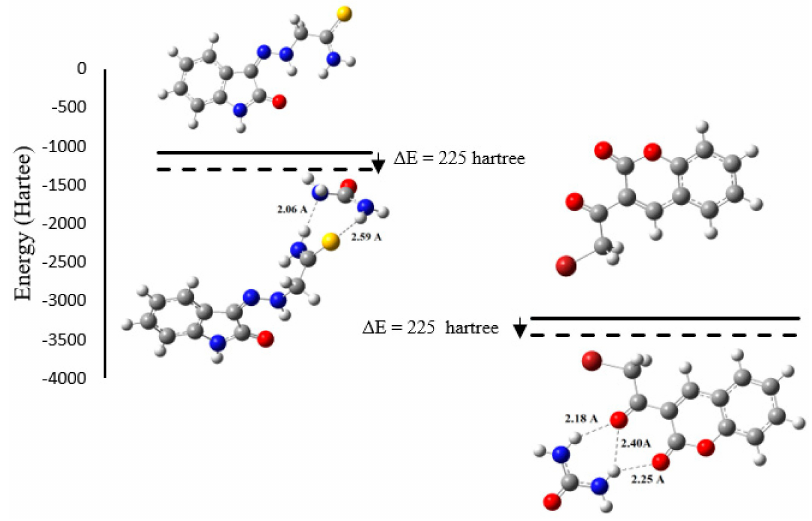
Figure 1. Energetic diagram of starting materials in the presence and absence of DES (dotted